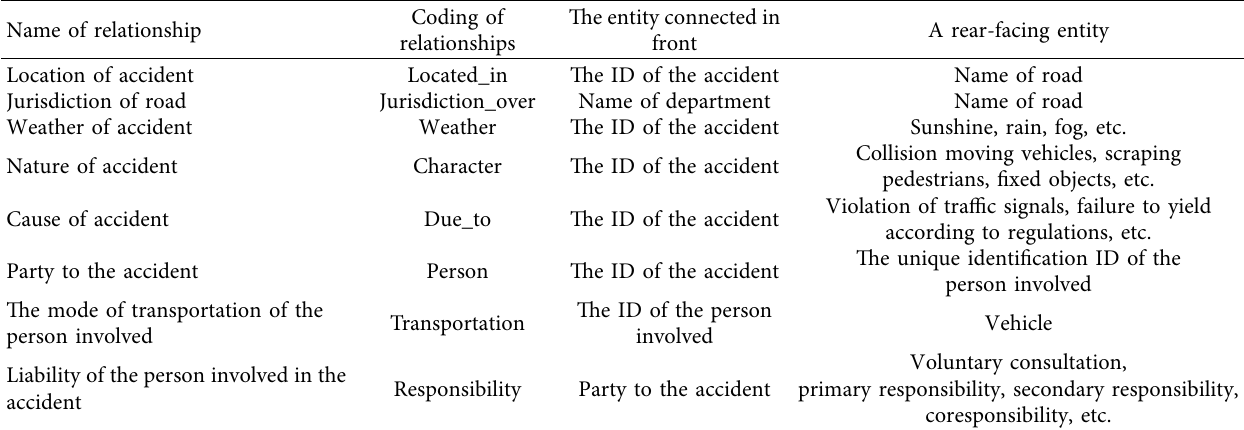
Table 2: Traffic accident area relation